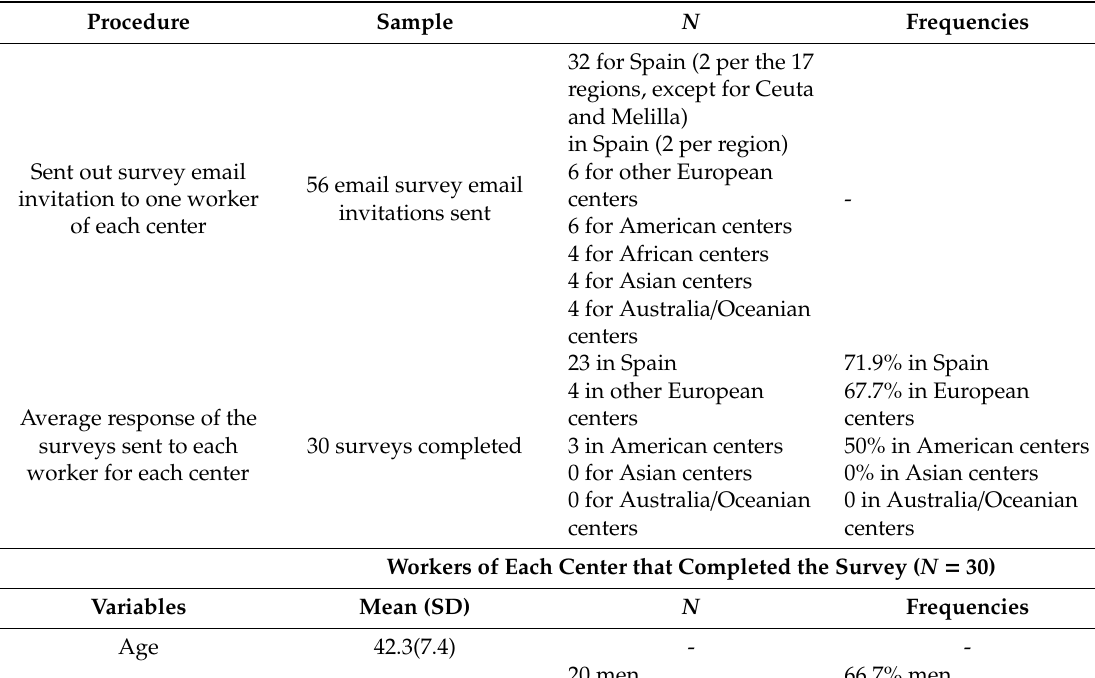
Table 1. Demographics data of the study